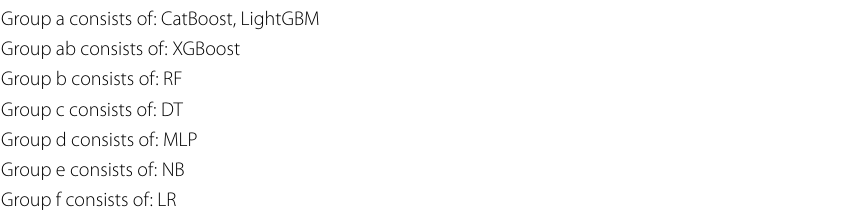
Table 39 HSD test groupings after ANOVA of AUC for the classifier factor Group a consists of: CatBoost,